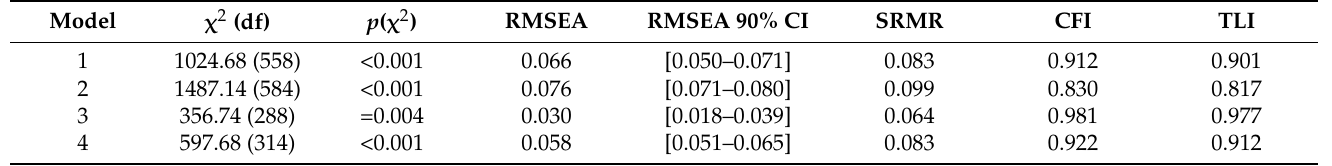
Table 1. Comparison of the fit indices of the four models